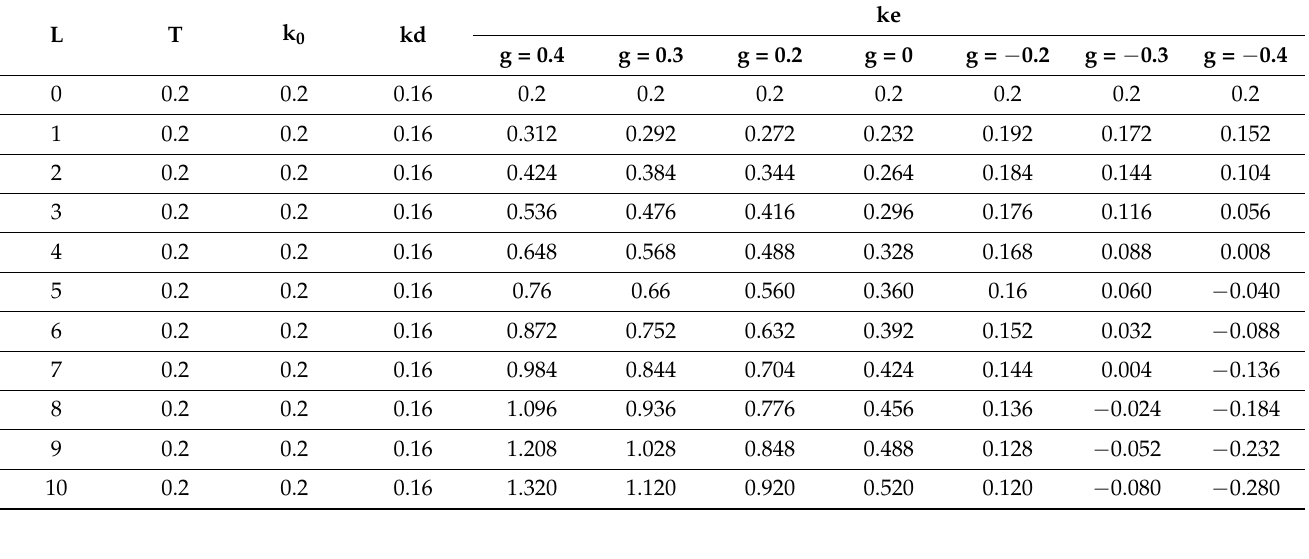
-0.4-0.200.20.40.60.811.21.4